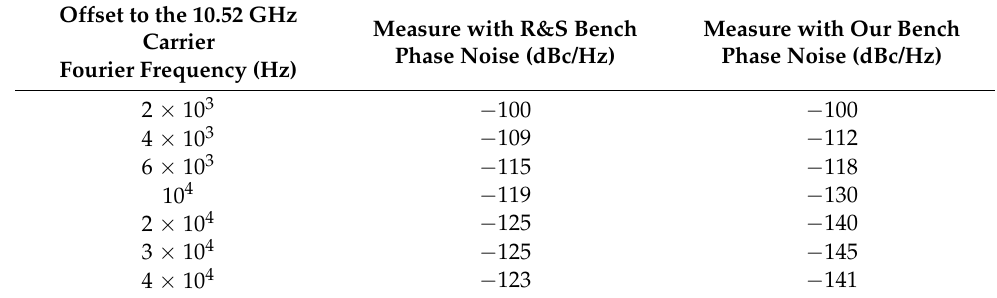
Table 2. Phase noise of an OEO with an output power of 5 dBm at 10.52 GHz, measured by our instrument and by the commercial Rohde and Schwarz (R&S)